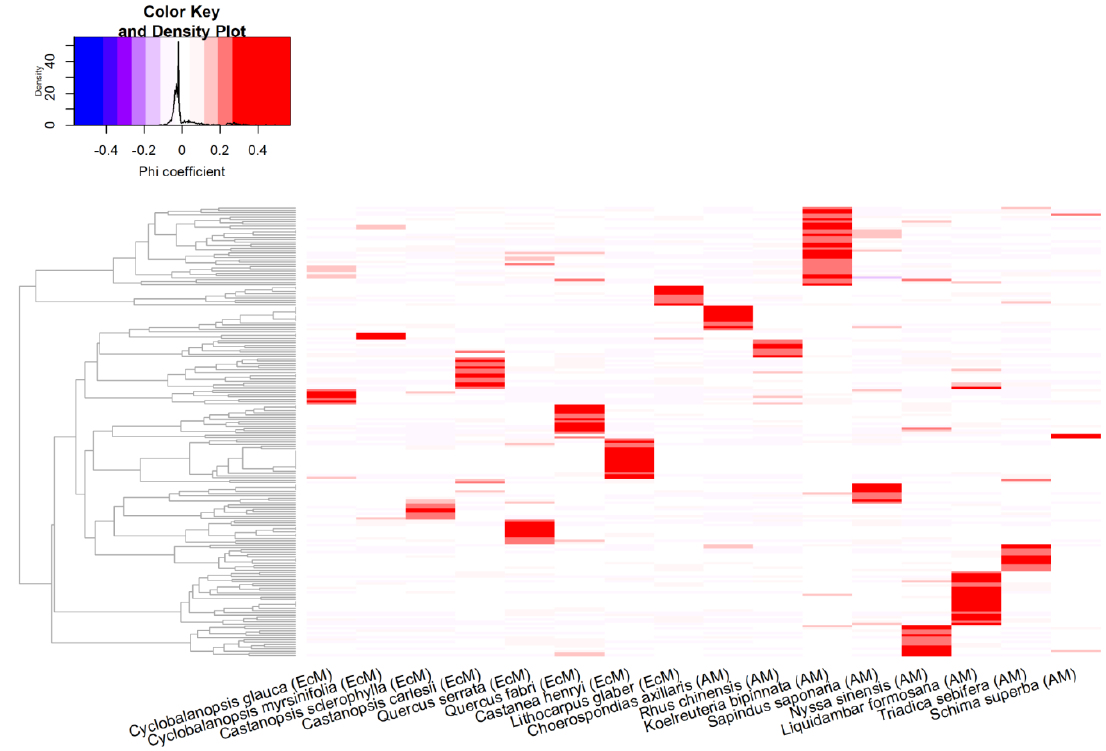
Figure 5. Heat map showing the distribution patterns of the 200 fungal OTUs with the highest phi specialization coefficients, ordered according to a hierarchical clustering of the phi coefficients, among the 16 tree species.